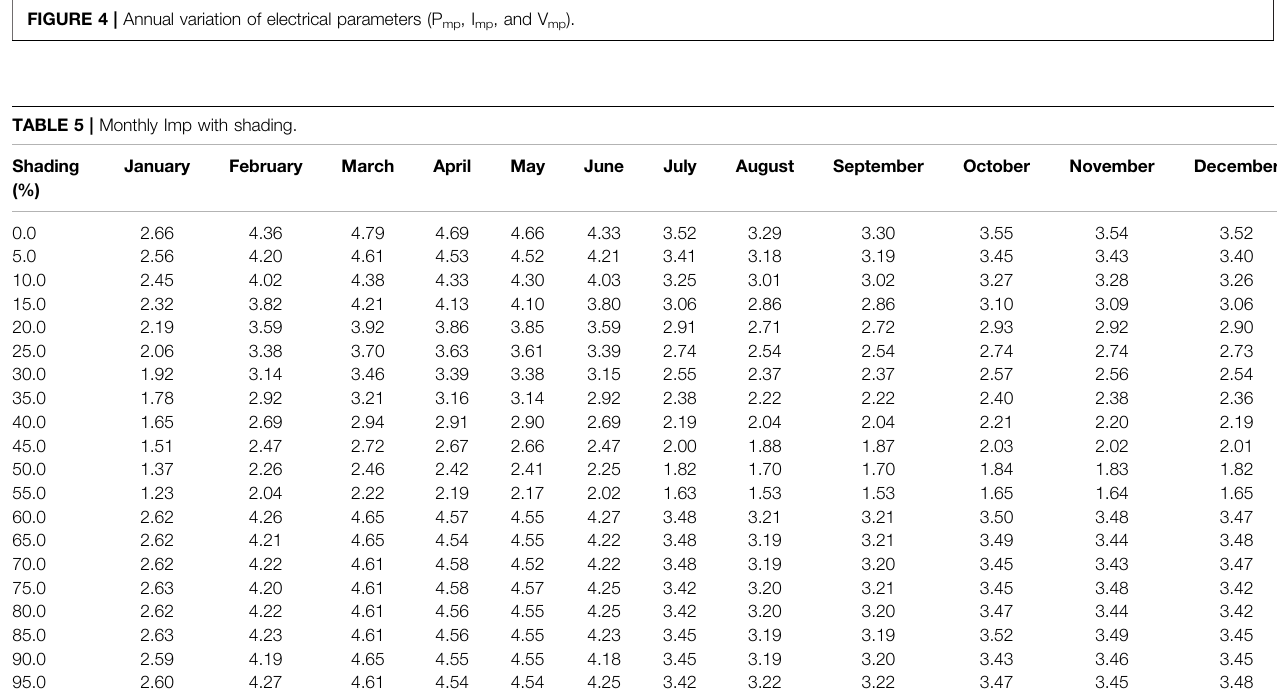
FIGURE 4 | Annual variation of electrical parameters (P mp , I mp , and V mp ).